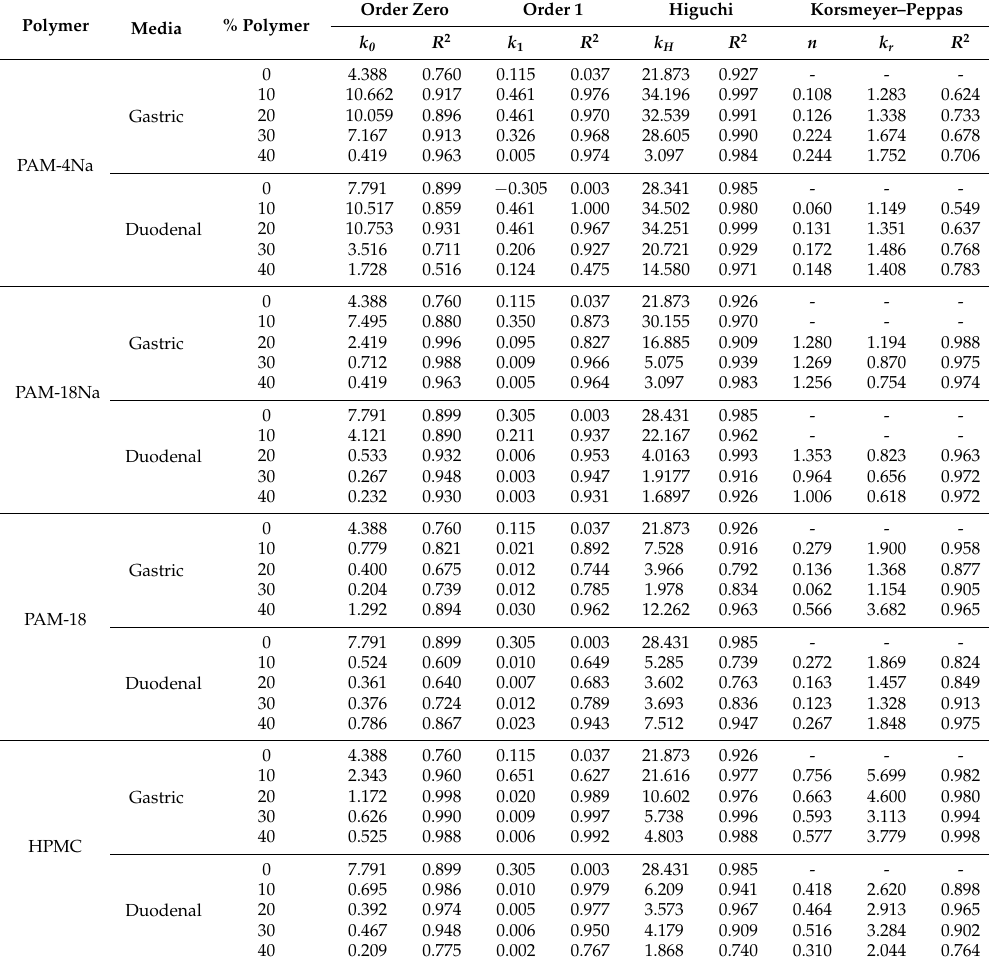
Table 7. Parameters and coefficients of determination of several kinetic models of